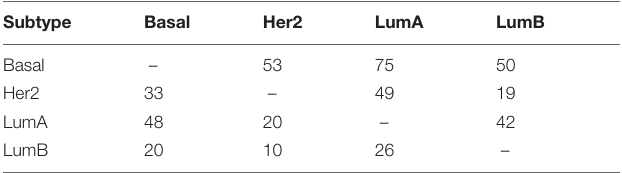
TABLE 4 | The correlation of P -values between